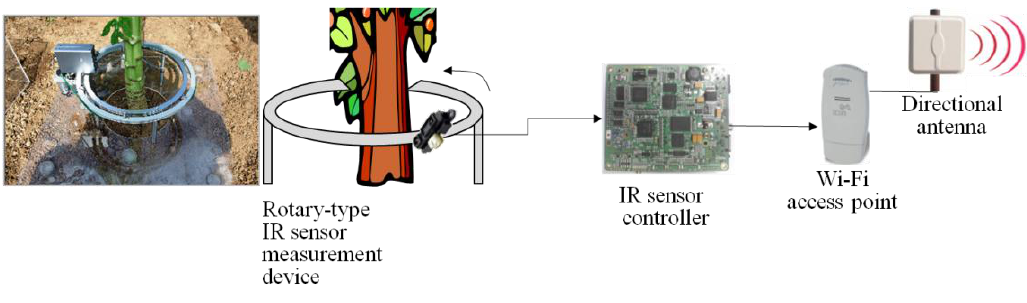
Figure 11. Rotary-type plant growth measurement device.